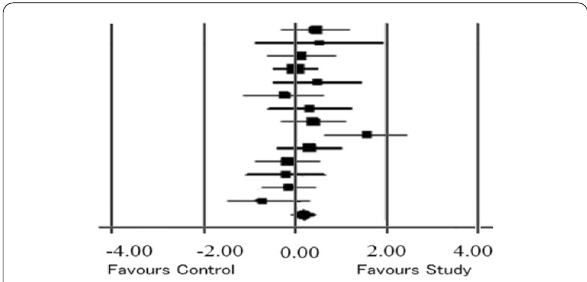
Fig. 4 Risk of bias: each risk of bias item presented as percentages across all included